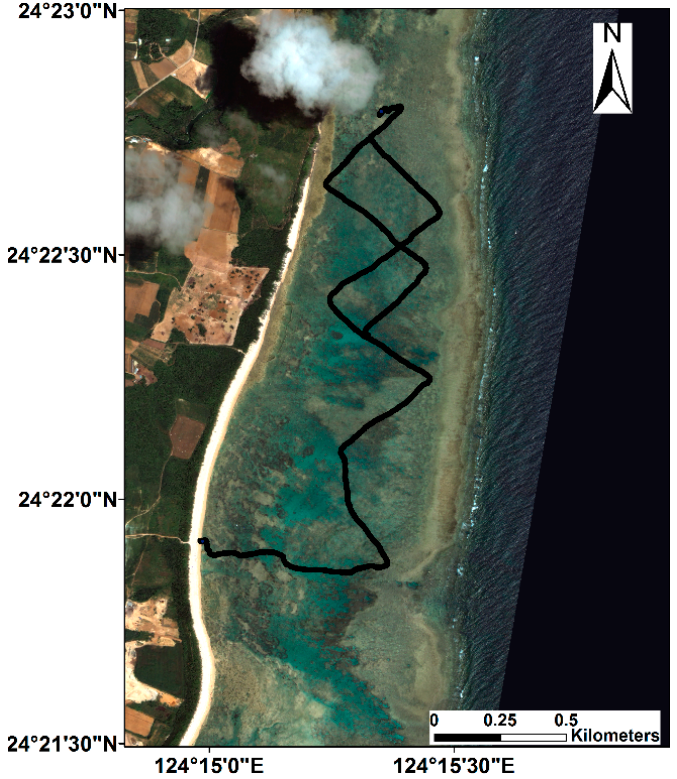
Figure 3. The field survey path over Shiraho study area, Ishigaki Island, Japan.